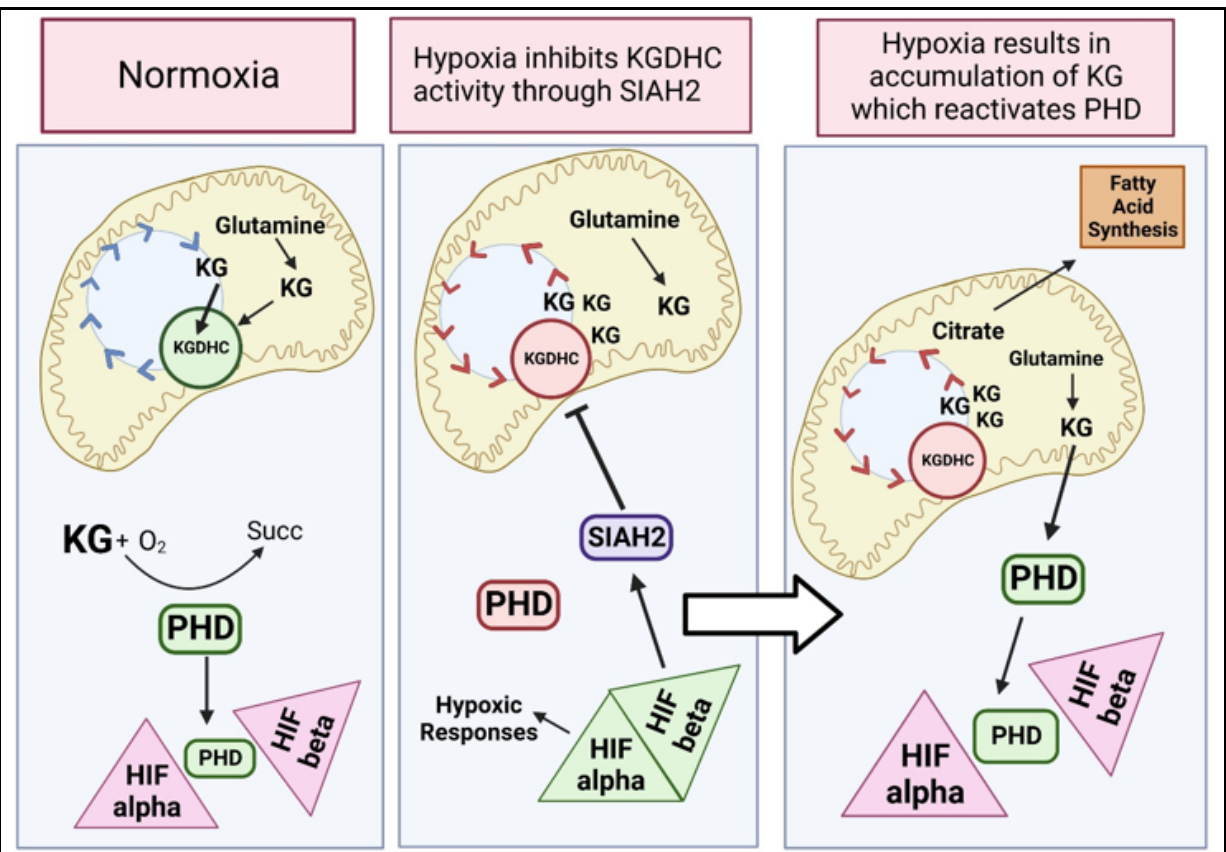
Figure 6. α -ketoglutarate dehydrogenase complex (KGDHC) interactions with HIF (hypoxia induc- ible factor). Normoxia. The tricarboxylic acid (TCA) cycle, α -ketoglutarate (KG) is converted to suc-